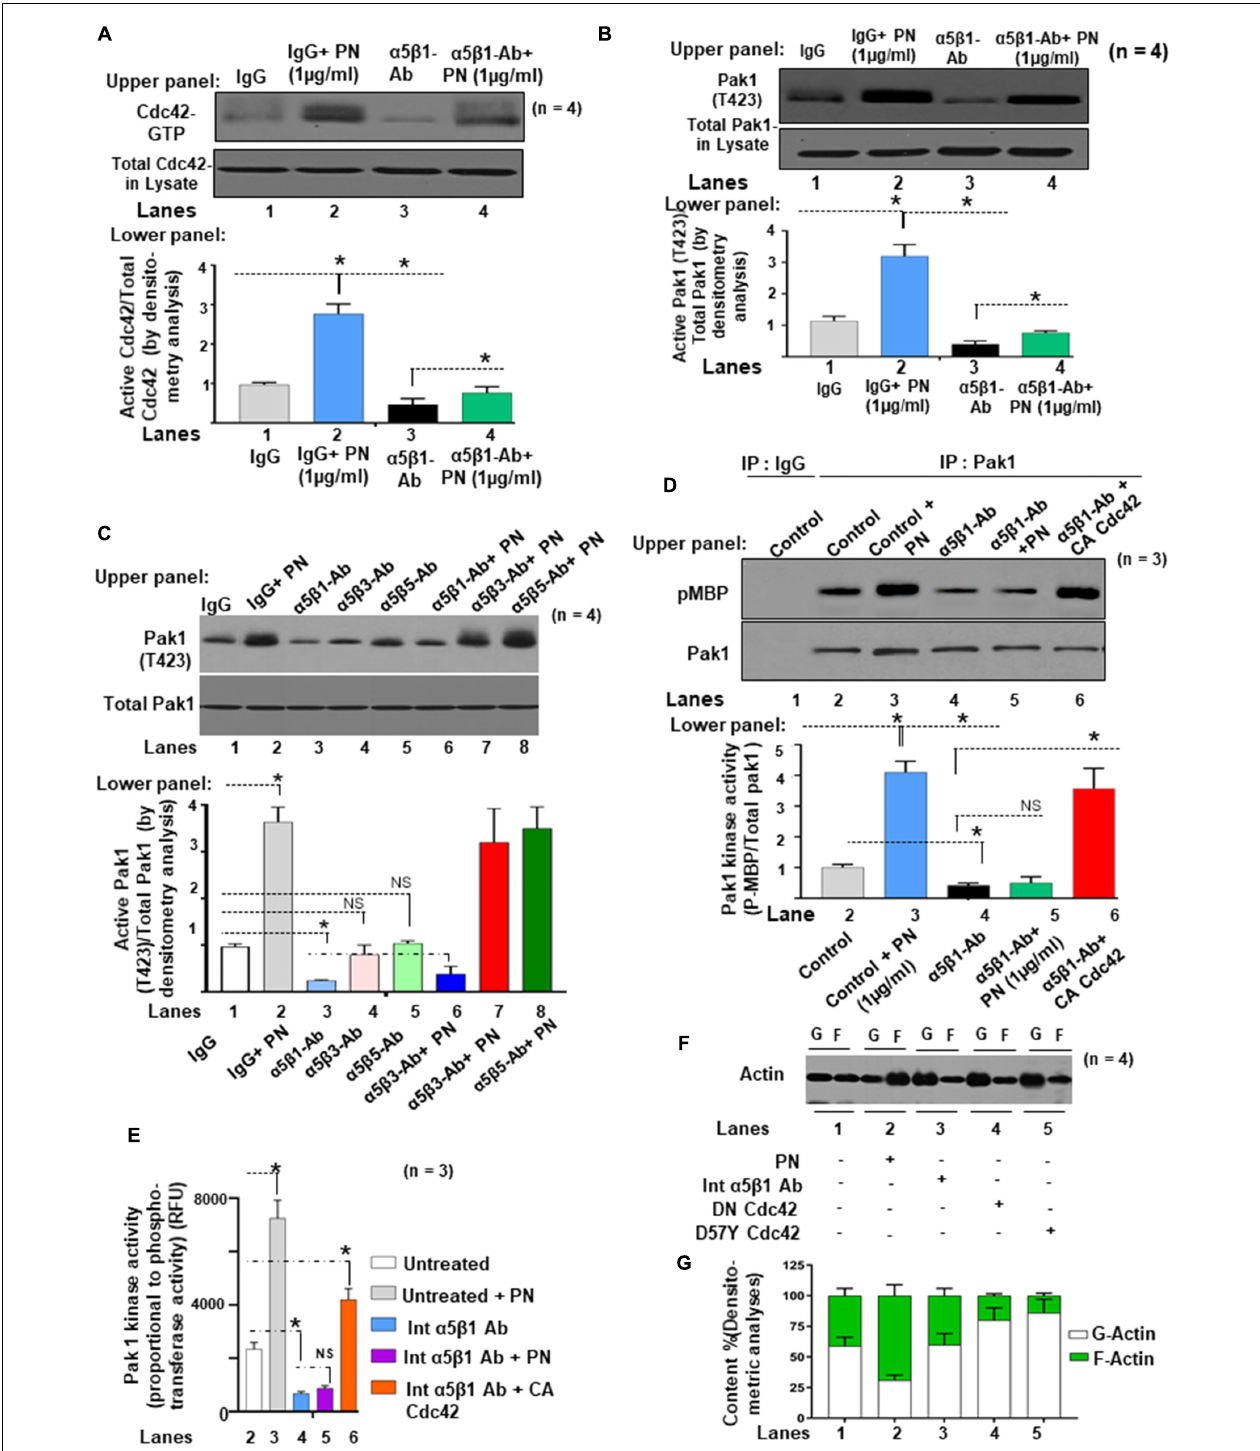
FIGURE 4 | PN/integrin β 1-regulated Cdc42 activation is associated with stimulation of both the autophosphorylation and the kinase activity of Pak1 and actin cytoskeletal assembly in the VIC ex vivo cultures isolated from ED 17.5 mice mitral valves. (A) Upper panel: Cell lysates were harvested from growth-arrested VIC cultures that were either treated with or without 1 µ g/ml of PN for 1 h (in serum-starved condition), or first treated with 5 µ g/ml of both α 5 and β 1 integrin blocking antibodies for 2 h and then treated with 1 µ g/ml of PN for 1 h. Cell lysates were prepared, and Cdc42-GTP was pulled-down from the lysates on GTP-loaded PBD-GST beads. The relative amounts of the activation of Cdc42 were quantified by normalizing the amount of bound Cdc42 to that of total Cdc42 in the lysates.